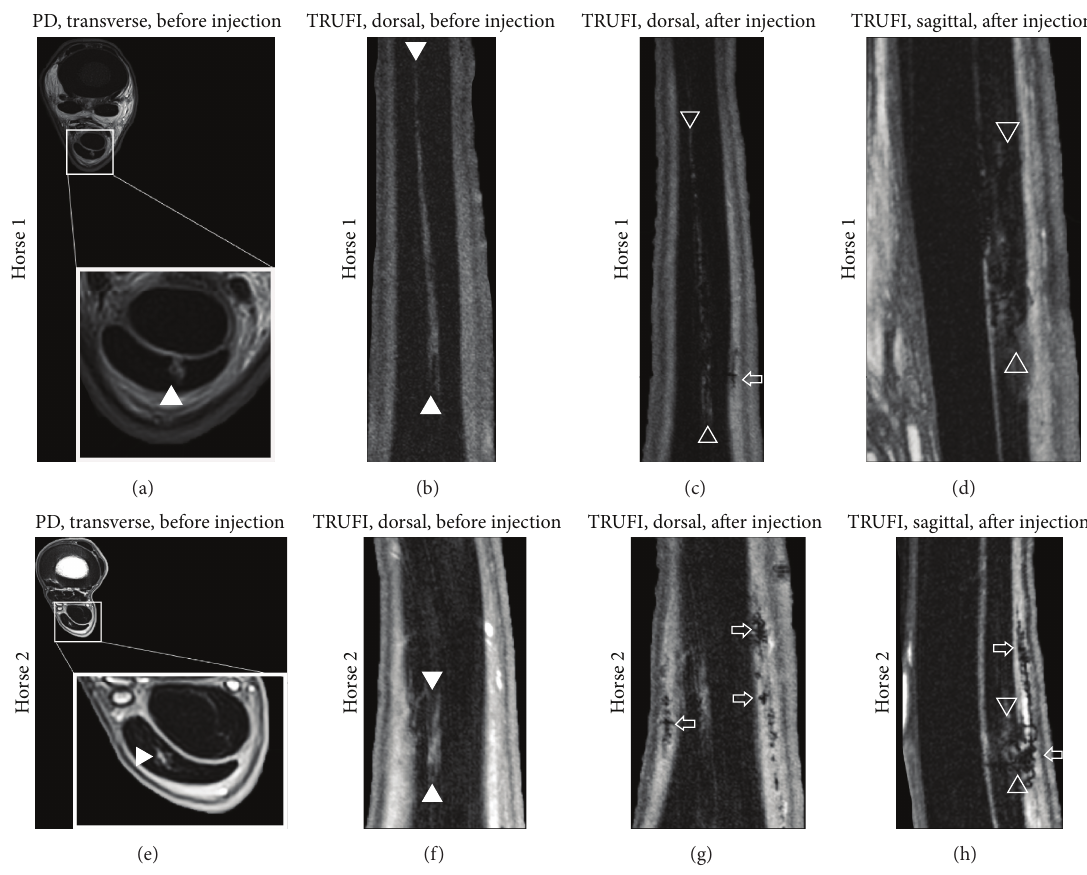
Figure 8: MRI of iatrogenic, SDFT lesions before (a, b, e, f) and after (c, d, g, h) injection of SPIO-treated cells. Solid arrowheads delineate the tendon lesion in preinjection images. Open arrowheads indicate SPIO-treated cells within the tendon lesion after injection. The SPIO-treated cells are seen as small, heterogeneous clusters of dark signal. The open, horizontal arrows indicate SPIO-treated cells distributed throughout the tissue layers surrounding the